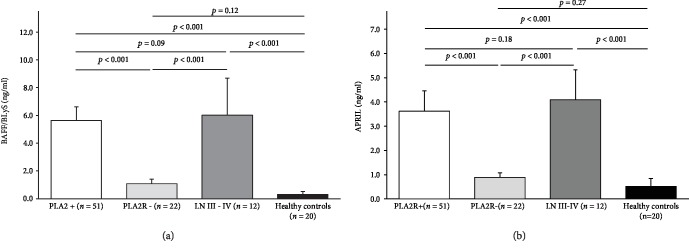
BAFF/BLyS and APRIL baseline serum levels in PMN patients and in controls. (a) BAFF/BLyS baseline serum levels in PMN patients with anti-PLA2R antibodies are significantly higher than those in patients without anti-PLA2R antibodies (5.64 ± 0.97 vs. 1.08 ± 0.33 ng/mL, p < 0.001; white and gray histogram, respectively), while no significant difference was observed with those from patients with lupus nephritis (6.01 ± 2.68 ng/mL, p = 0.09; dark gray histogram). Finally, in healthy volunteers, BAFF/BLyS was detected at very low concentration (0.31 ± 0.21 ng/mL, p = 0.12 vs. PLA2R-negative patients; black histogram). (b) APRIL baseline serum levels in PMN patients with anti-PLA2R antibodies are significantly higher than those in patients without anti-PLA2R antibodies (3.62 ± 0.84 vs. 1.08 ± 0.33 ng/mL, p < 0.001; white and gray histogram, respectively), while no significant difference was observed with those from patients with lupus nephritis (4.09 ± 2.24 ng/mL, p = 0.18; dark gray histogram). Finally, in healthy volunteers, APRIL was detected at very low concentration (0.52 ± 0.32 ng/mL, p = 0.27 vs. PLA2R-negative patients; black histogram). Mann-Whitney U test for nonparametric data. Data in the graphs are expressed as mean ± standard deviation.